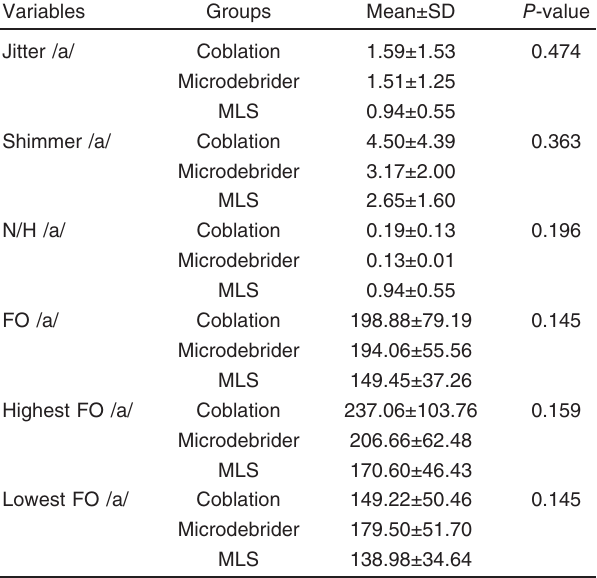
Table 14 Comparison between groups of the study regarding different variables after intervention /u/ Variables Groups